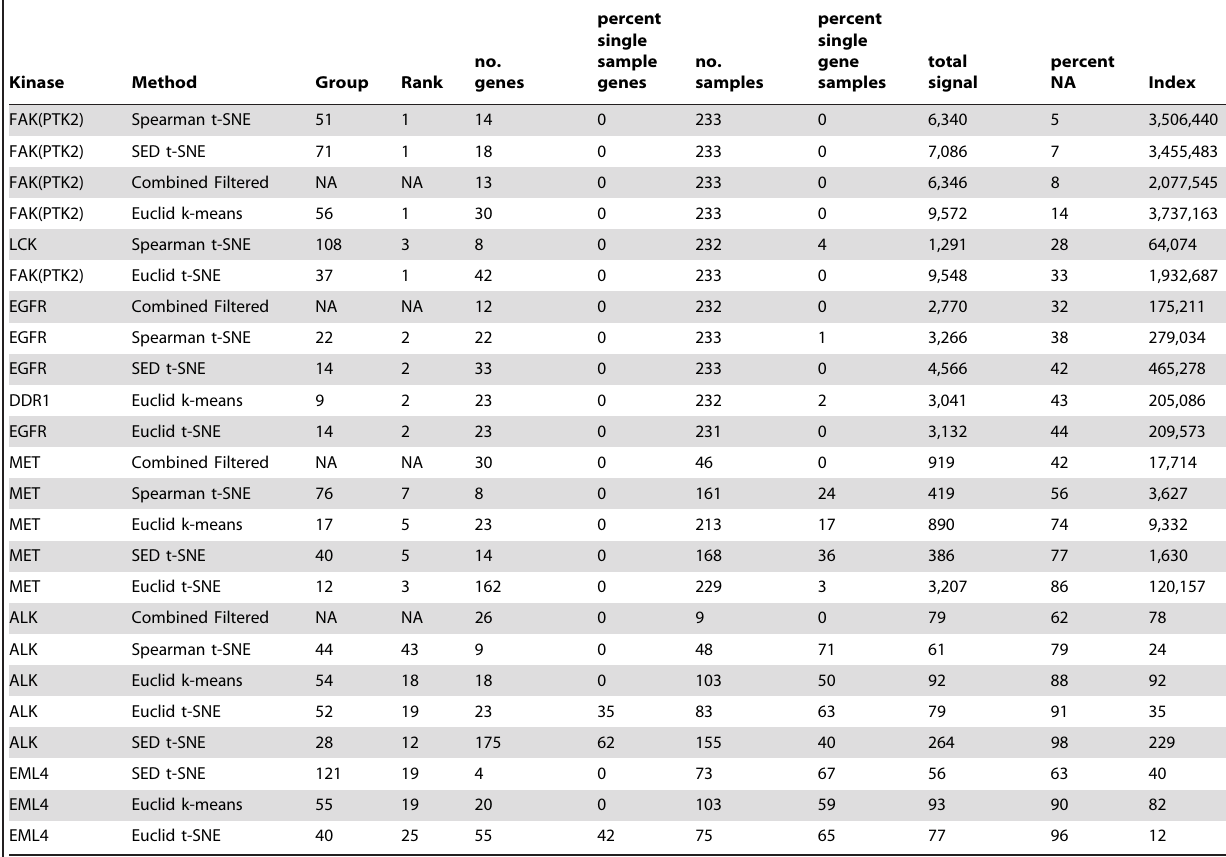
Table 2. Summary of key